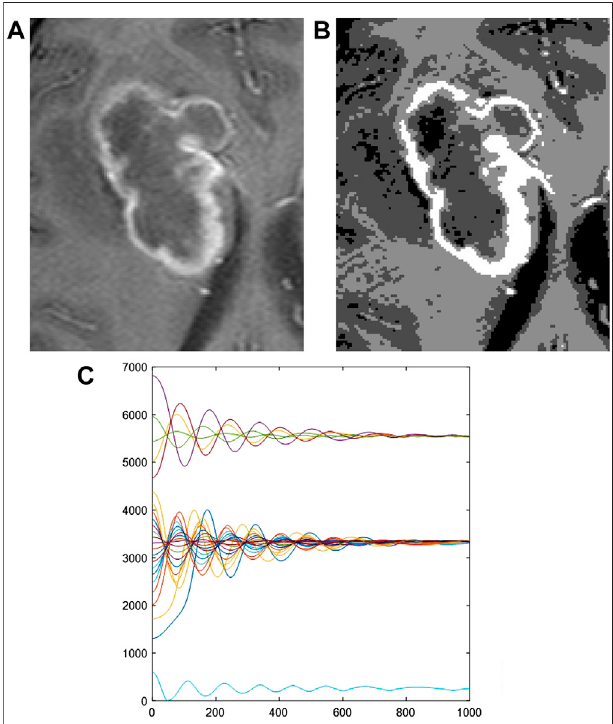
FIGURE 1 | Clustering of digital levels. (A) Original image, (B) clustered image, (C) Time evolution of digital